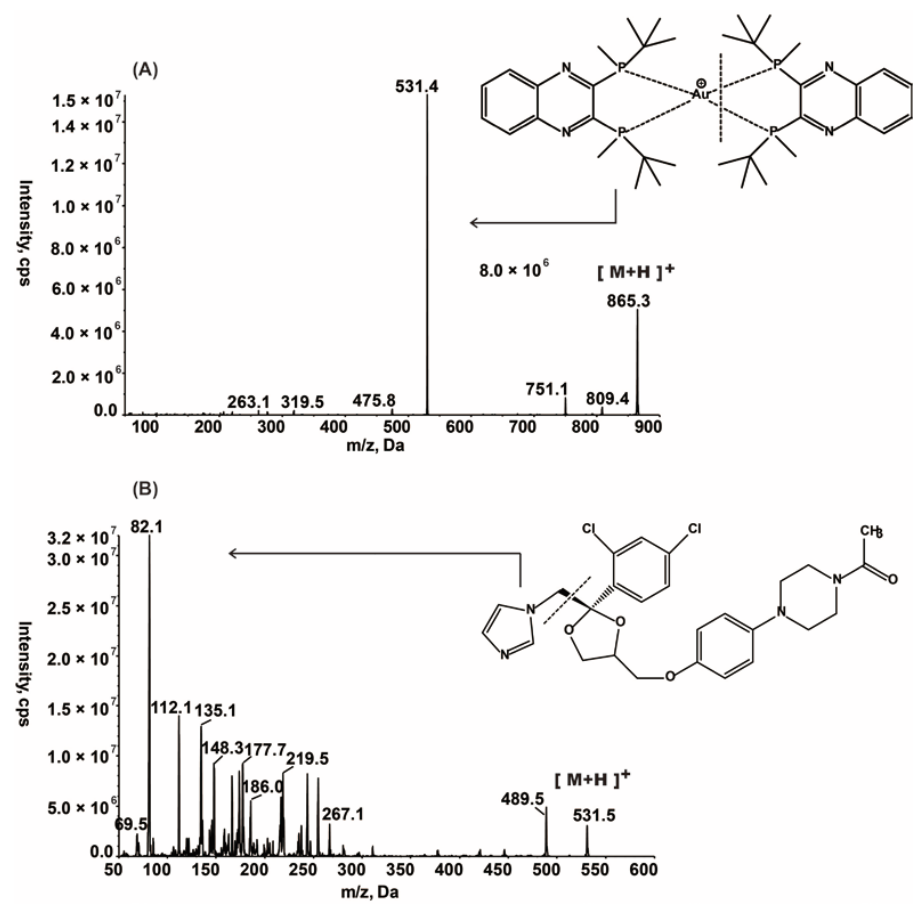
Figure 1. Product ion mass spectra of ( A ) GC20 ( m / z 865.3 → 531.4), scan range 50–900 amu; ( B ) IS (Ketoconazole) ( m / z 531.5 → 82.1), scan range 50–600 amu in the positive ionization mode.